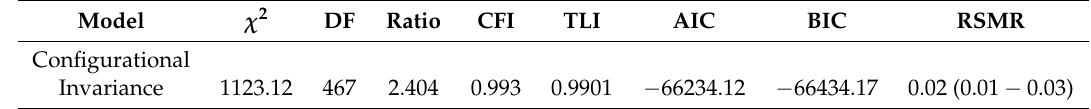
Table 3. Invariance stimation with five